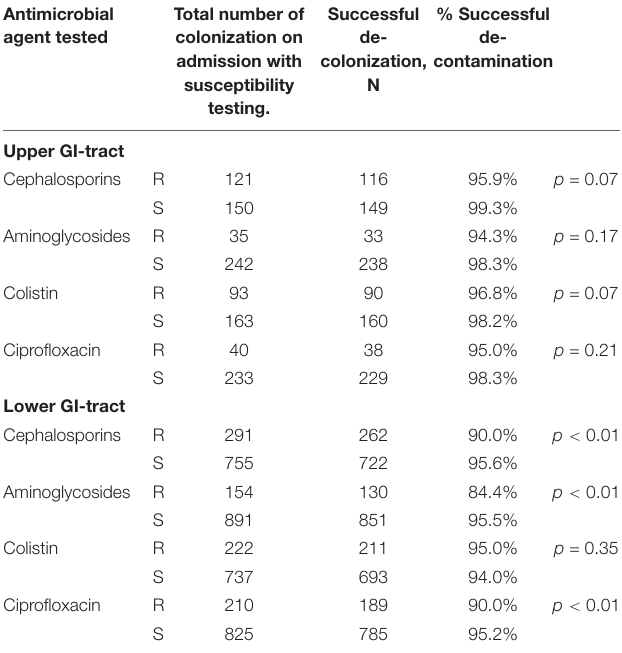
TABLE 3 | Rates of successful decontamination according to location and antimicrobial agent, for resistant and sensitive strains. Antimicrobial Total number of agent tested colonization on